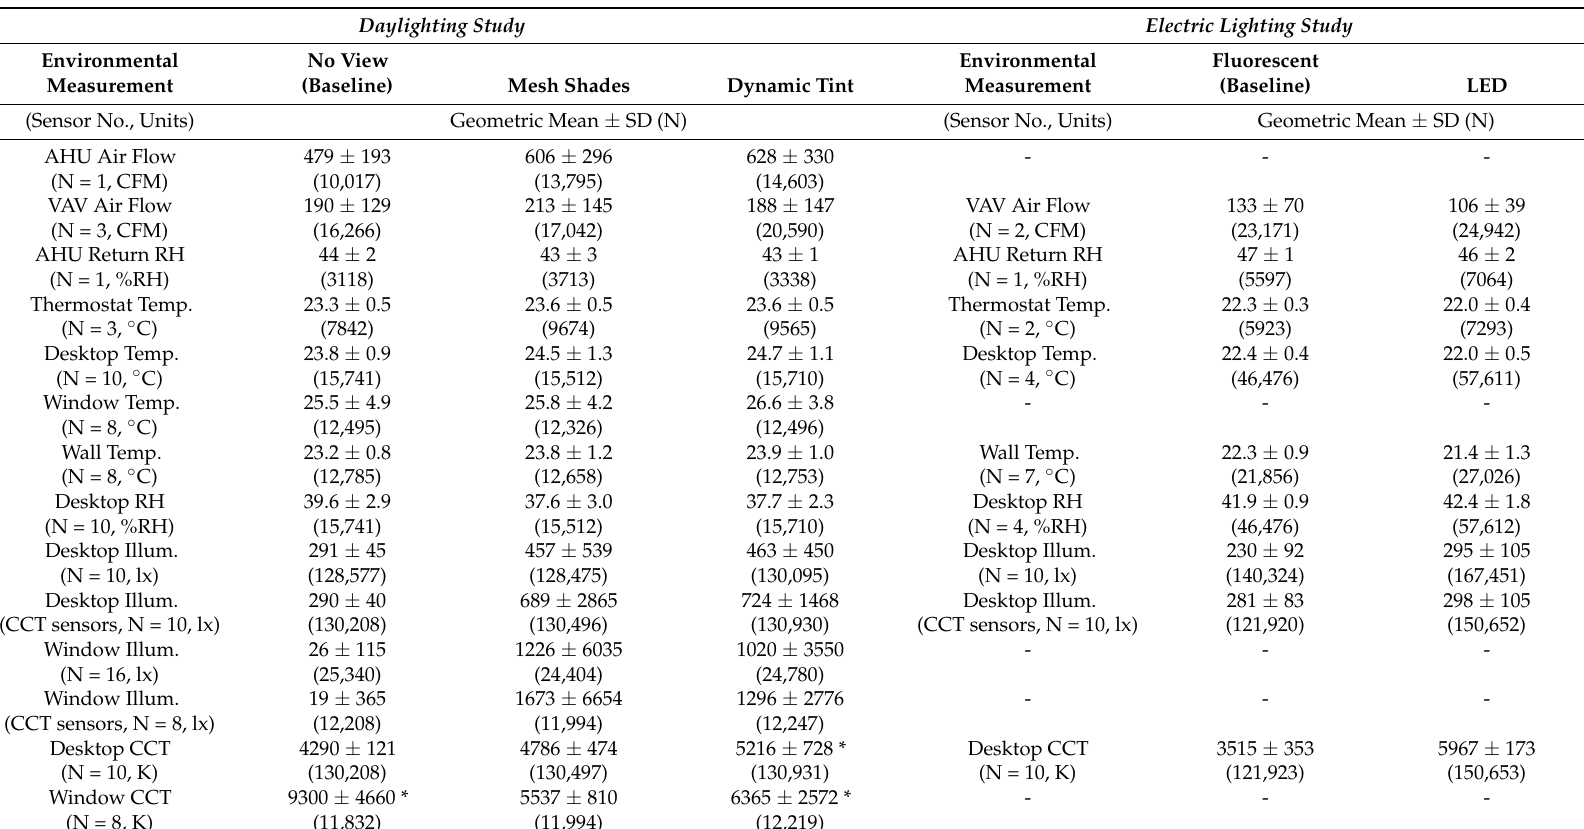
Table 4. Geometric mean ( ± SD) of environmental conditions and observation numbers (N) measured by sensor networks and building systems during work hours (06:00–18:00) during the daylighting and electric lighting studies. Daylighting Study Electric Lighting Study Environmental No View Measurement (Baseline) Mesh Shades Dynamic Tint (Sensor No., Units) Geometric Mean ± SD (N) (Sensor No., Units) Geometric Mean ± SD (N)